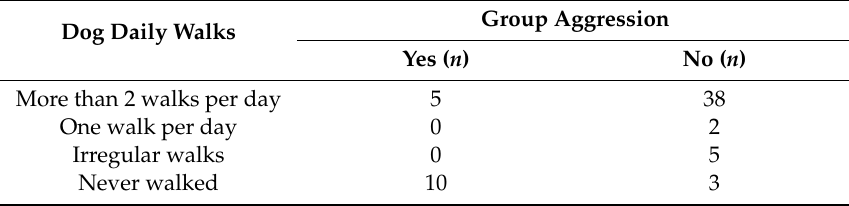
Table 12. Comparison of dog daily walks and episodes of group aggression towards other